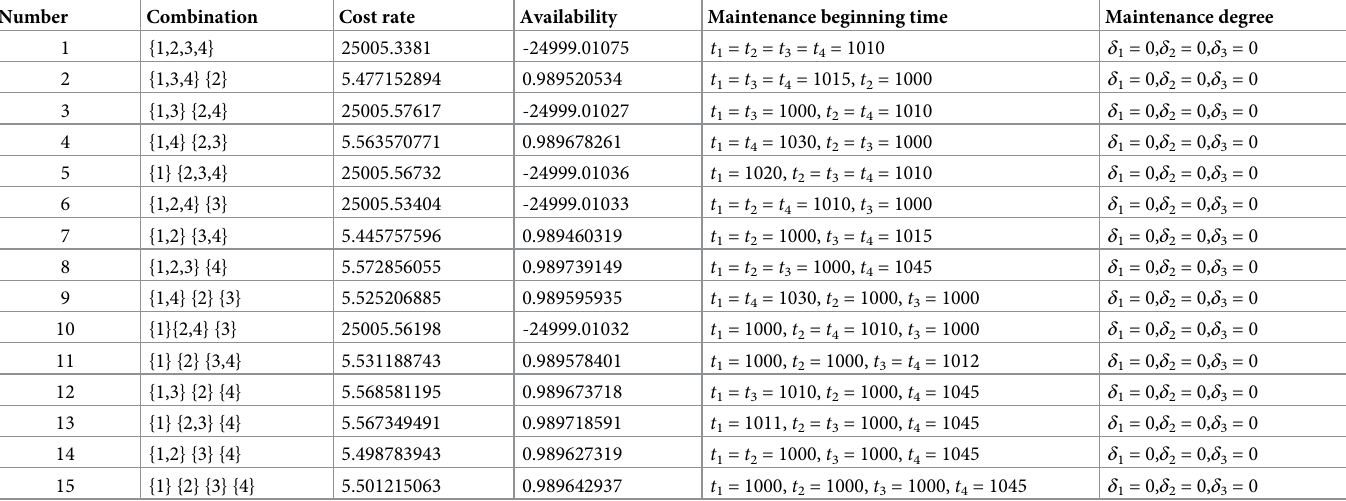
Table 2. Optimization results analysis when follow-up maintenance cost and downtime is small.